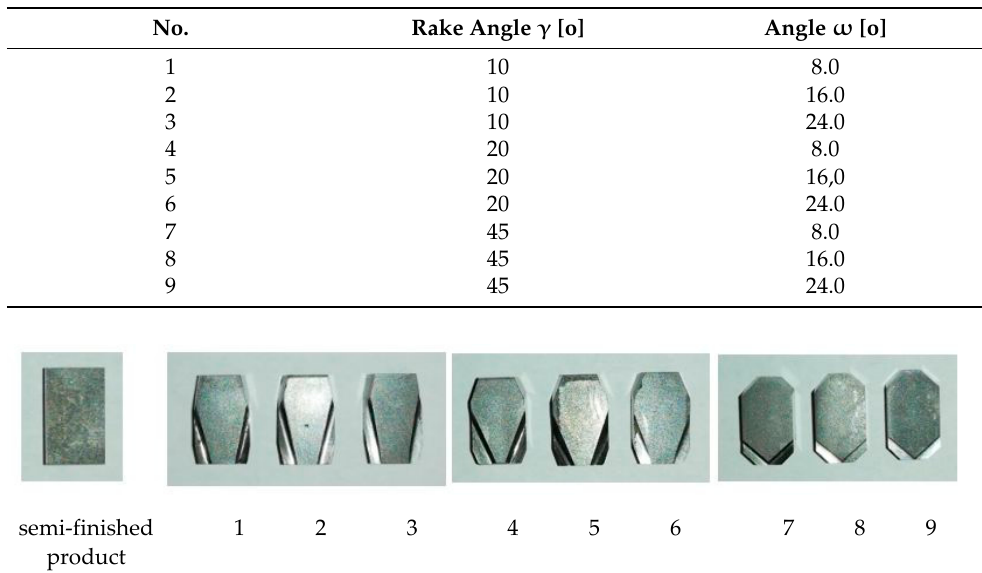
Table 4. Geometric parameters of cutting inserts.